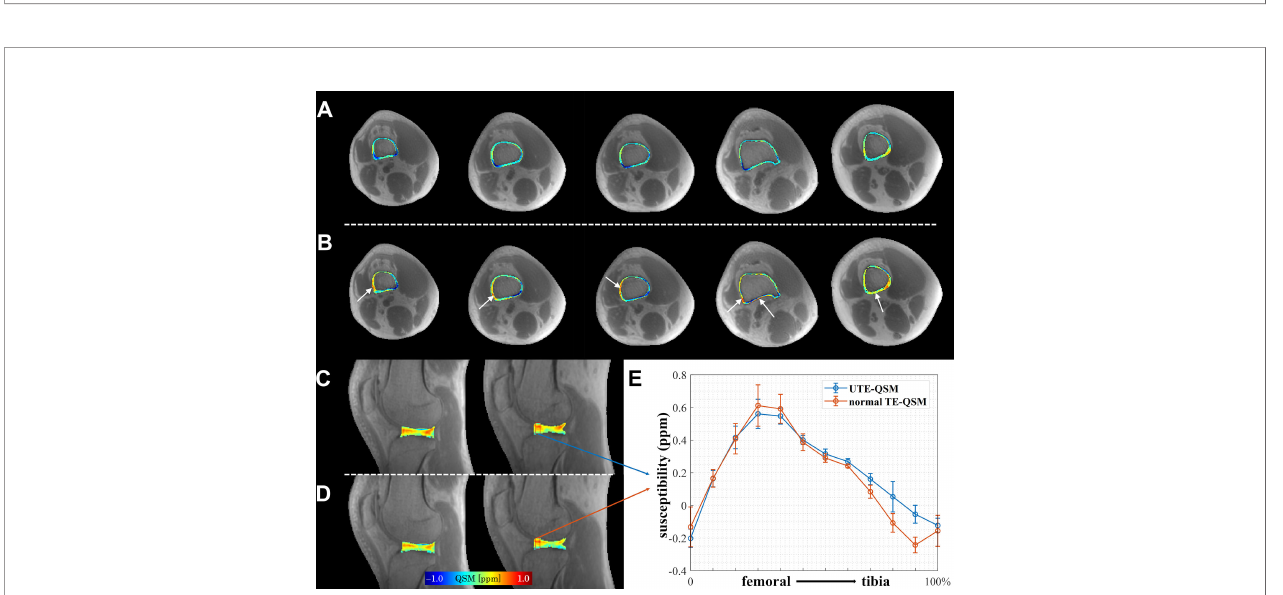
QSM (D) were similar. (E) shows the susceptibility pro fi les of UTE-QSM and normal TE-QSM from femoral to tibia cartilages in the selected red box (5×12 pixels) on one healthy volunteer. Data are presented as mean±standard deviation. Each column of cortical bone in (A, B) or articular cartilage in (C, D) represents a typical image slice from an individual subject in this study.